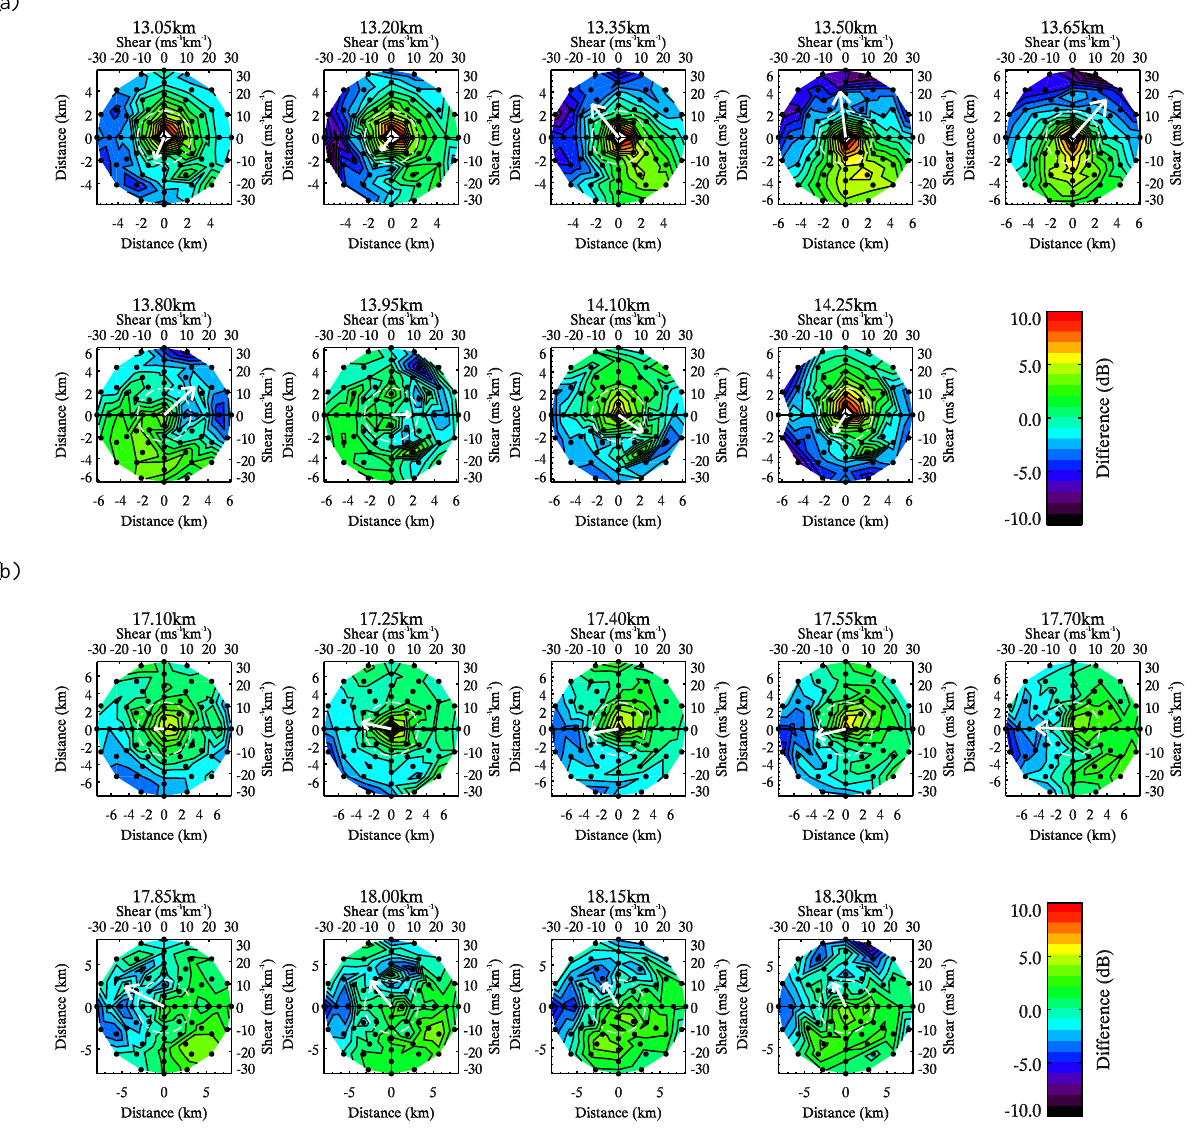
Fig. 5. Horizontal maps of echo power from (a) 13.05km to 14.25 km and (b) 17.10km to 18.30km averaged from 22:39 to 00:46LT. White arrows indicate the wind shear direction and magnitude. The white dashed circles correspond to a zenith angle of 10 ◦ . The black dots indicate the direction of the radar